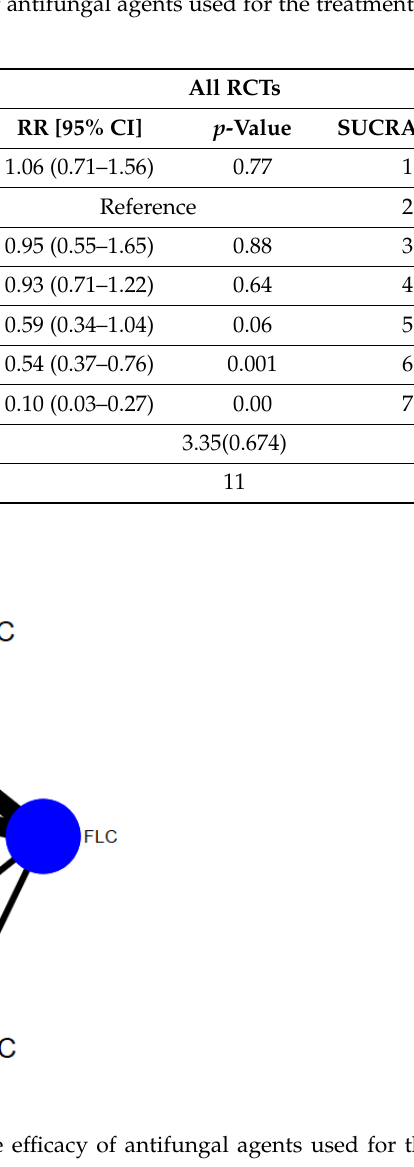
Figure 7. SUCRA ranking curve for the efficacy of antifungal agents used for the treatment of OPC among HIV-infected adults (mycological cure). Abbreviations: CLT — clotrimazole, FLC — fluconazole, ITC — itraconazole, KTC — ketoconazole,